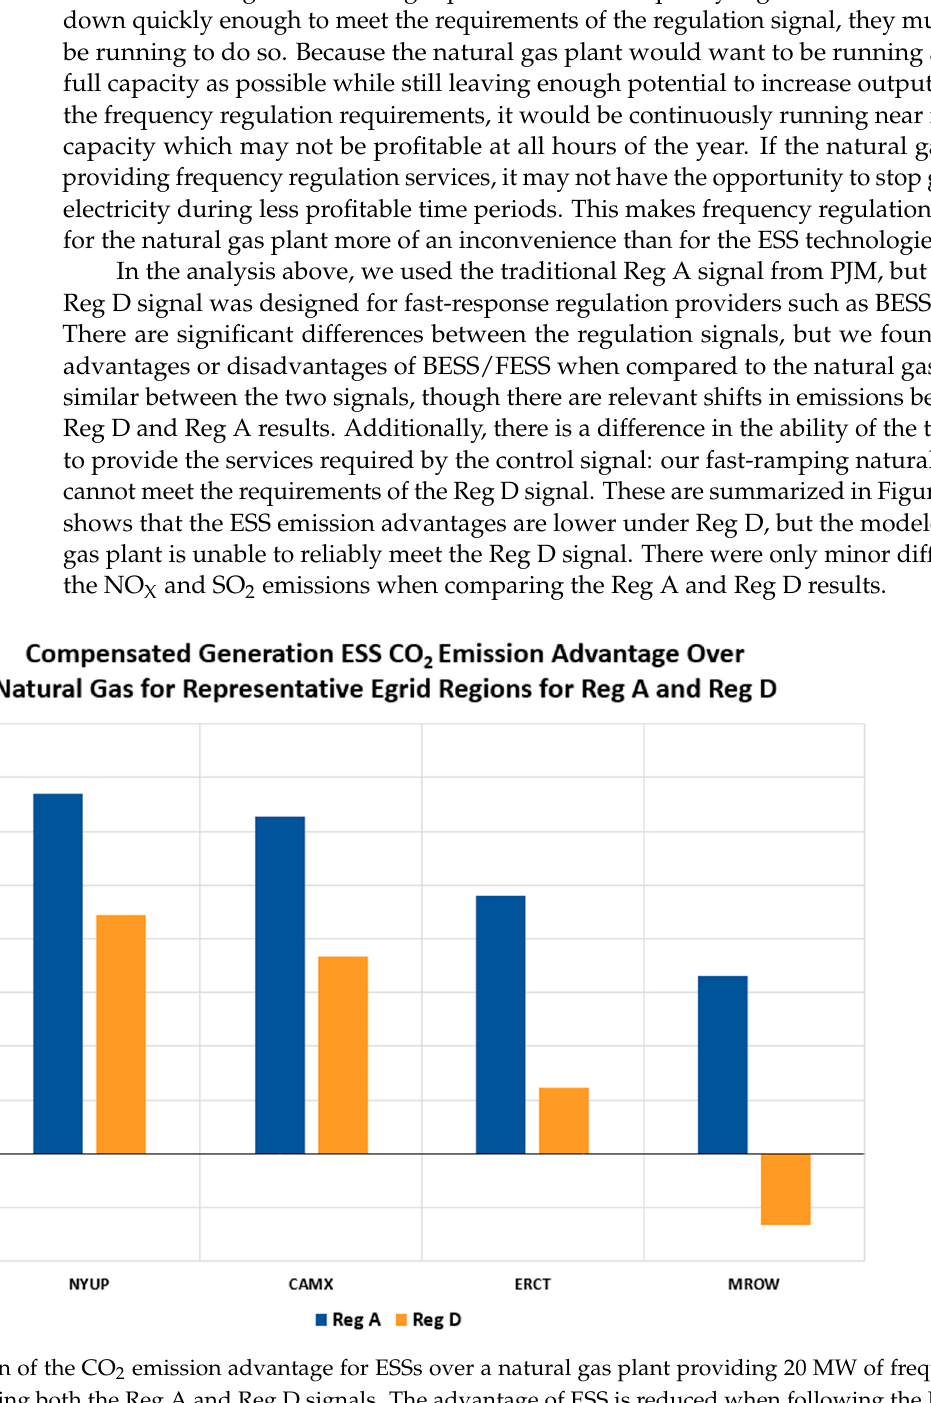
generation capacity in PJM [21]. Consequently, large scale changes to the installed gener ‐ ation, such as transitioning from fossil fuels to renewable generation, will have much larger effects on emissions than changes to frequency regulation technology. A final consideration is the trend over time as the grid mix shifts. Because the BESS and FESS technologies have emission effects that are related to the marginal generation sources, a shift in generation mix can affect estimates of their emissions, presumably im ‐ proving as the grid becomes cleaner. We investigated historical changes in MEFs for the years in which consistent MEF data were available, focusing on CO 2 because the difference between the BESS/FESS and natural gas plant CO 2 emissions was the smallest. The CO 2 MEFs from 2006–2017 are quite consistent, as shown in Figure 10. None of the eGRID subregions had an annual change of more than 13% in the CO 2 MEFs. The largest overall change can be seen in NYUP where there is a 29% decrease in the CO 2 MEFs from their peak in 2009 to their low in 2017, but the year ‐ to ‐ year change did not exceed 13%. Apply ‐ ing the largest percent difference over the analyzed time period in MEFs to our analysis does not change which emission technology had lower emissions for CO 2 in any eGRID subregion. The MEFs would have to change significantly for the ESS emissions to be the same as the natural gas emissions. A MEF of 1.21 tonnes of CO 2 per MWh would result in equal ESS and natural gas CO 2 emissions. This is three times higher than the current CO 2 MEFs for the average eGRID subregion. A MEF of 5.2 kg of NO X per MWh would result in equal ESS and natural gas NO X emissions. This is at least 22 times lower than the current NO X MEFs for all the subregions. A MEF of 6.6 kg of SO 2 per MWh would result in equal ESS